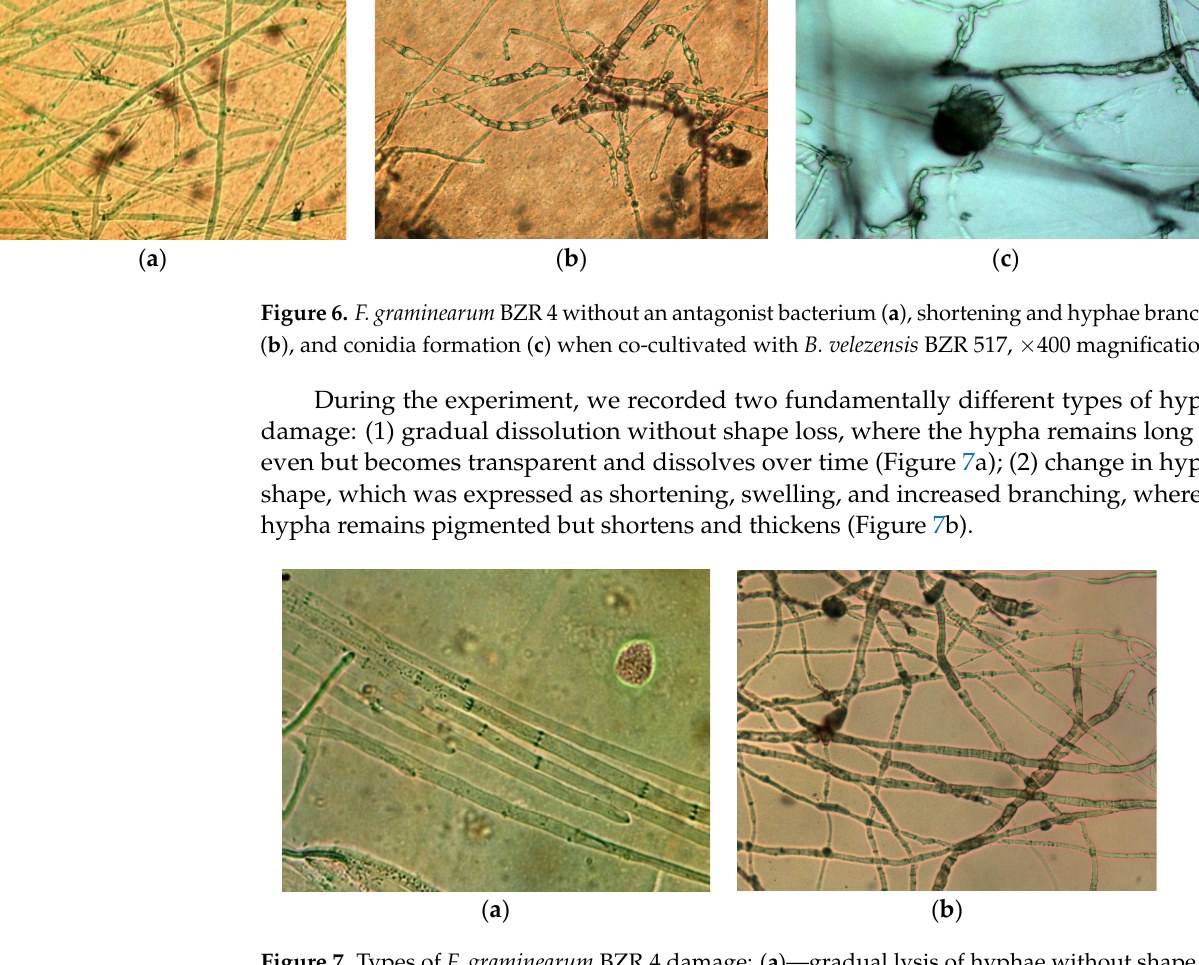
Figure 5. F. graminearum BZR 4: ( a )—control ( F. graminearum BZR 4 without antagonist bacterium); ( b )—colonization of B. velezenzis BZR 336 g hyphae F. graminearum BZR 4; ( c )—hyphae lysis of F. graminearum BZR 4 during incubation with antagonist bacterium B. velezenzis BZR 336 g, ×400 mag- nification.